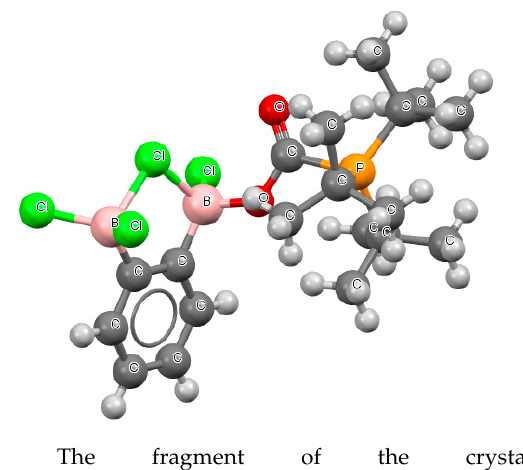
Figure 7. The fragment of the crystal structure of ( µ 2 -chloro)-( µ 2 -1,2-phenylene)–trichloro-(tri-tbutylphosphinocarboxylato)-di-boron (refcode GAYRUV).